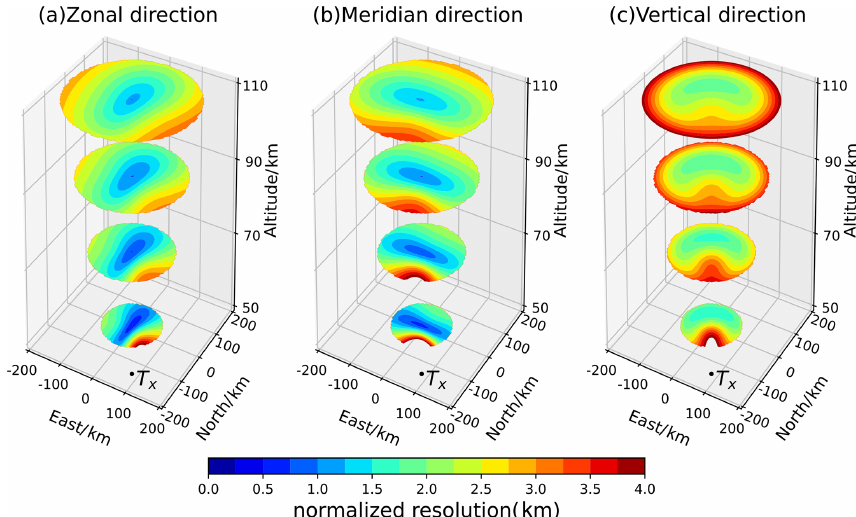
Figure 8. The 3D contour plot of the normalized resolution distribution for a multistatic radar link whose baseline length is 180km and whose transmitter is 30 ◦ south by east of the receiver. The black dots represent the position right above the transmitter, and the receiving array is at the origin of the axes. Panels (a–c) are the normalized resolution distributions in the zonal, meridional and vertical directions, respectively. The subplot’s four slice circles from bottom to top are the horizontal section at 50, 70, 90 and 110km height, respectively. The region whose elevation angle of the receiver is less than 30 ◦ is not shown, and therefore the slice circles become larger from the bottom to the top. Normalized resolution values that exceed 4km (which corresponds to 16km resolution) are not